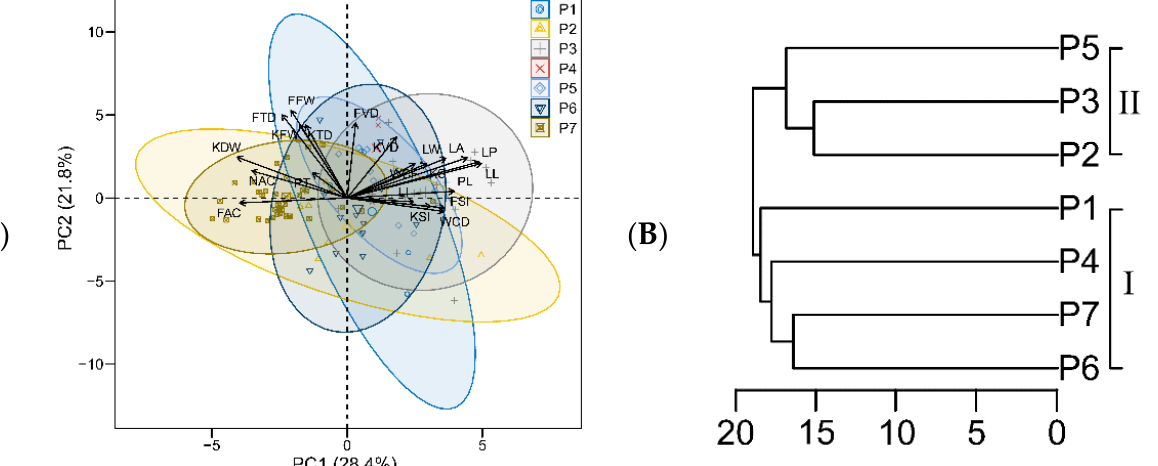
Figure 2. Biplot of the principal component analysis ( A ) and clustering relationship of the seven populations by UPGMA ( B ) based on 21 traits.